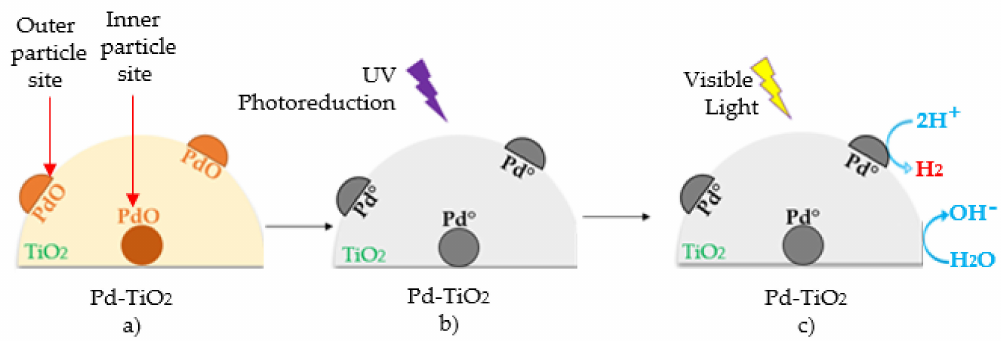
Figure 8. Schematic Representation of: ( a ) The synthesized photocatalysts following calcination at 500 ◦ C with most of the Pd being present as PdO, ( b ) The photoreduction of the PdO to Pd ◦ using a UV-Lamp for 1 h, ( c ) The H 2 production using a photoreduced Pd-TiO 2 , with molecular H 2 being generated on the